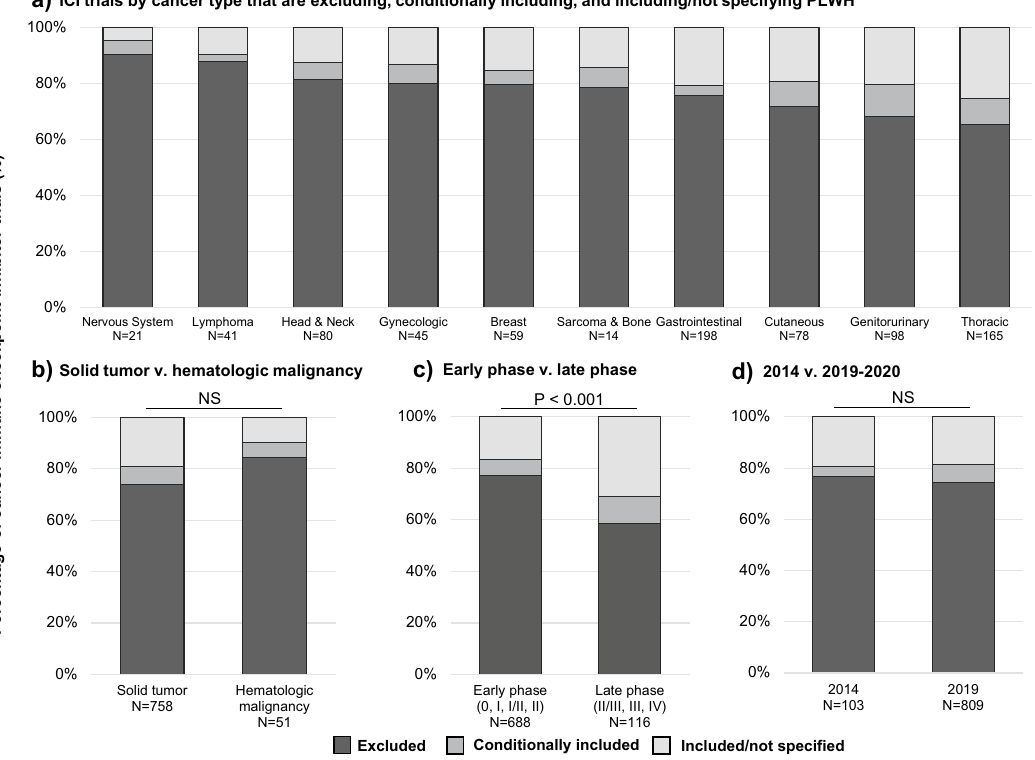
Figure 2. Percentage of cancer immune checkpoint inhibitor trials that excluded, conditionally included, and included/not specified PLWH. (a) Rate of 2019–2020 cancer immune checkpoint inhibitor trials excluding, conditionally including, and including/not specifying PLWH by grouped cancer type. Cancer types with fewer than 10 trials were excluded from this analysis. (b) Solid tumor versus hematologic malignancy 2019–2020 cancer immune checkpoint inhibitor trials that are excluding, conditionally including, and including/not specifying PLWH. (c) Early phase versus late phase 2019–2020 cancer immune checkpoint inhibitor trials that are excluding, conditionally including, and including/not specifying PLWH. Five trials that did not have trial phase listed on ClinicalTrials.gov were excluded from this analysis. (d) Cancer immune checkpoint inhibitor trials from 2014 versus 2019–2020 that are excluding, conditionally including, and including/not specifying PLWH. P-values shown reflect the comparison of trials excluding PLWH versus included/not specified trials by tumor type, phase, and trial year. NS not